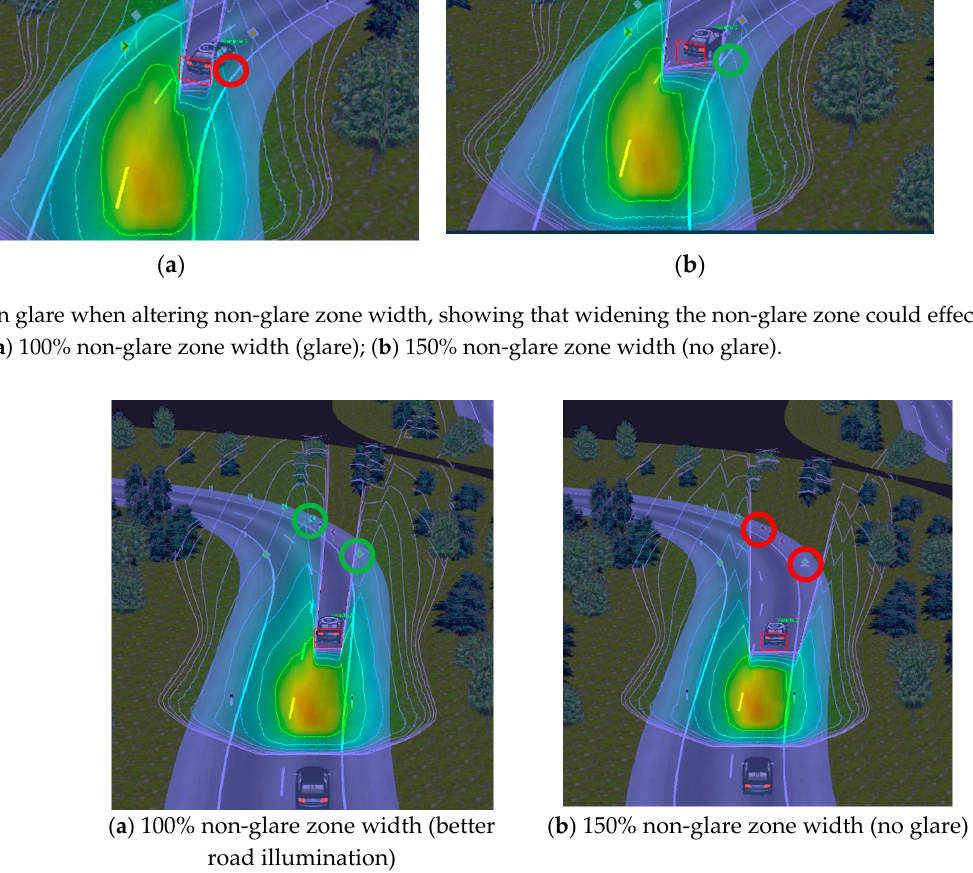
Figure 5. Effect on road illumination when altering the non-glare zone width, showing that a widened non-glare zone sacrifices road illumination. For example, the traffic signs circled on ( a ) are well illuminated; however, when the non-glare zone increases on ( b ), the signs are included in the non- glare zone and, thus, are not illuminated. This indicates the driver will have better and wider visi- bility with the narrower non-glare zone, which enhances driving safety.